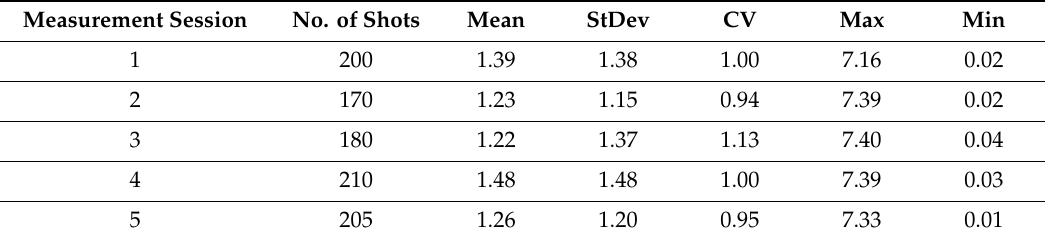
Table 1. The statistical parameters of shot angle of five measurement sessions (deg).